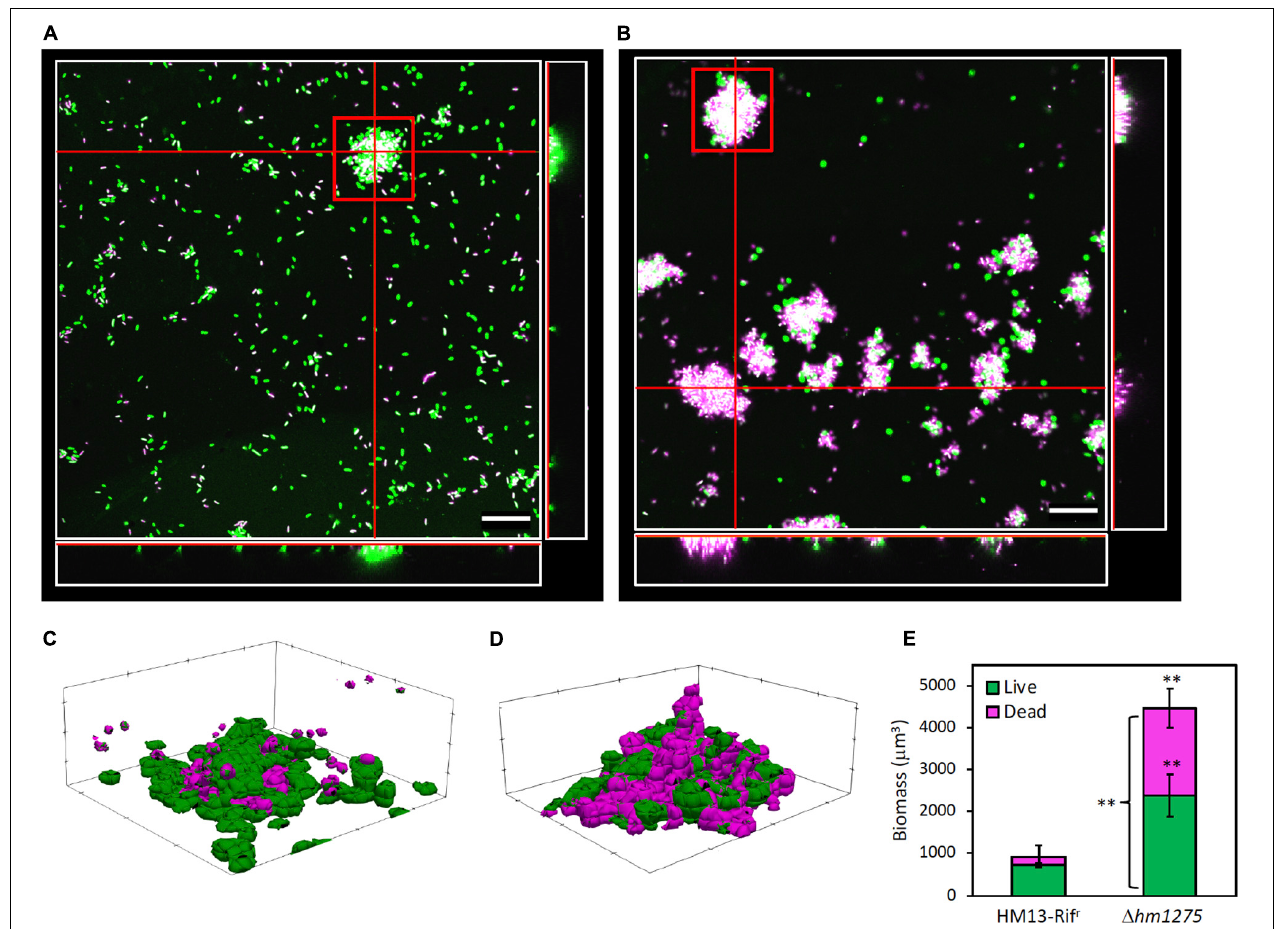
FIGURE 5 | Live/dead cell analysis of surface-associated cells of HM13-Rif r and (cid:49) hm1275 . Surface-associated cells of HM13-Rif r (A) and (cid:49) hm1275 (B) cultured in M79 + CA were observed by CLSM. Green, magenta, and white colors indicate living and dead cells, and merged colors, respectively. The white boxes at the right and bottom of each image show cross-sections at the vertical and horizontal red lines in the center white box, respectively. The central white box of each image shows a side-cross-section at the red lines in the right and bottom white boxes. The bars indicate 20 µ m. (C,D) Models of biofilm of HM13-Rif r (C) and (cid:49) hm1275 (D) in the red square in (A,B) were constructed with BiofilmQ and ParaView. (E) The biomass and live/dead ratio in biofilm were quantified with BiofilmQ. The data are the means ± standard errors of the values from three independent batches. Statistical analysis was performed for differences between HM13-Rif r and (cid:49) hm1275 using two-tailed unpaired Student’s t -test. ∗∗ indicates p <